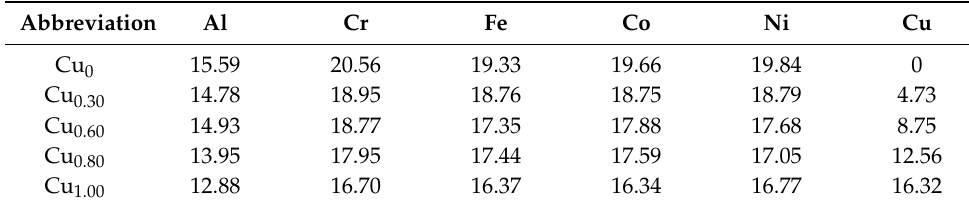
Table 4. Specific powder ratios and alloy abbreviations